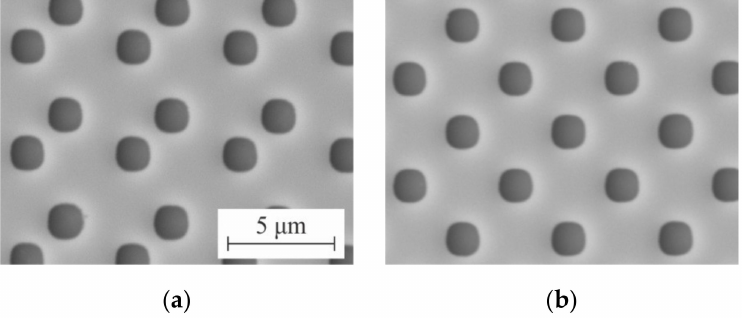
Figure 16. SEM microimages of 2D DSE structures written on DWL66+: general view of the test structure with shift of 1.6 µ m ( a ) and with shift of 2.5 µ m ( b